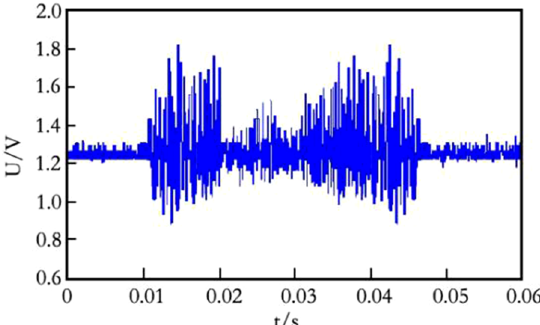
Fig. 6. The vibration waveform when the opening springs falls off.